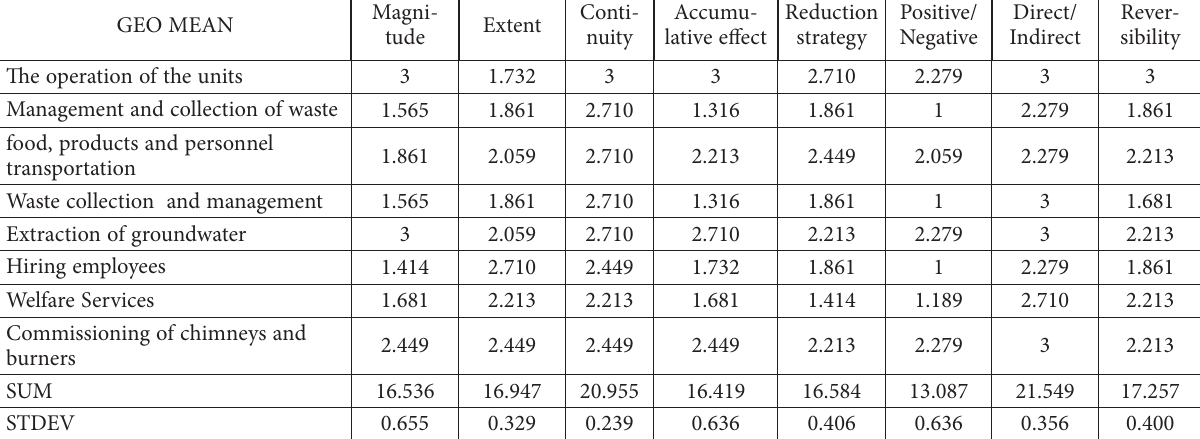
Table 3. Geo mean matrix of operational